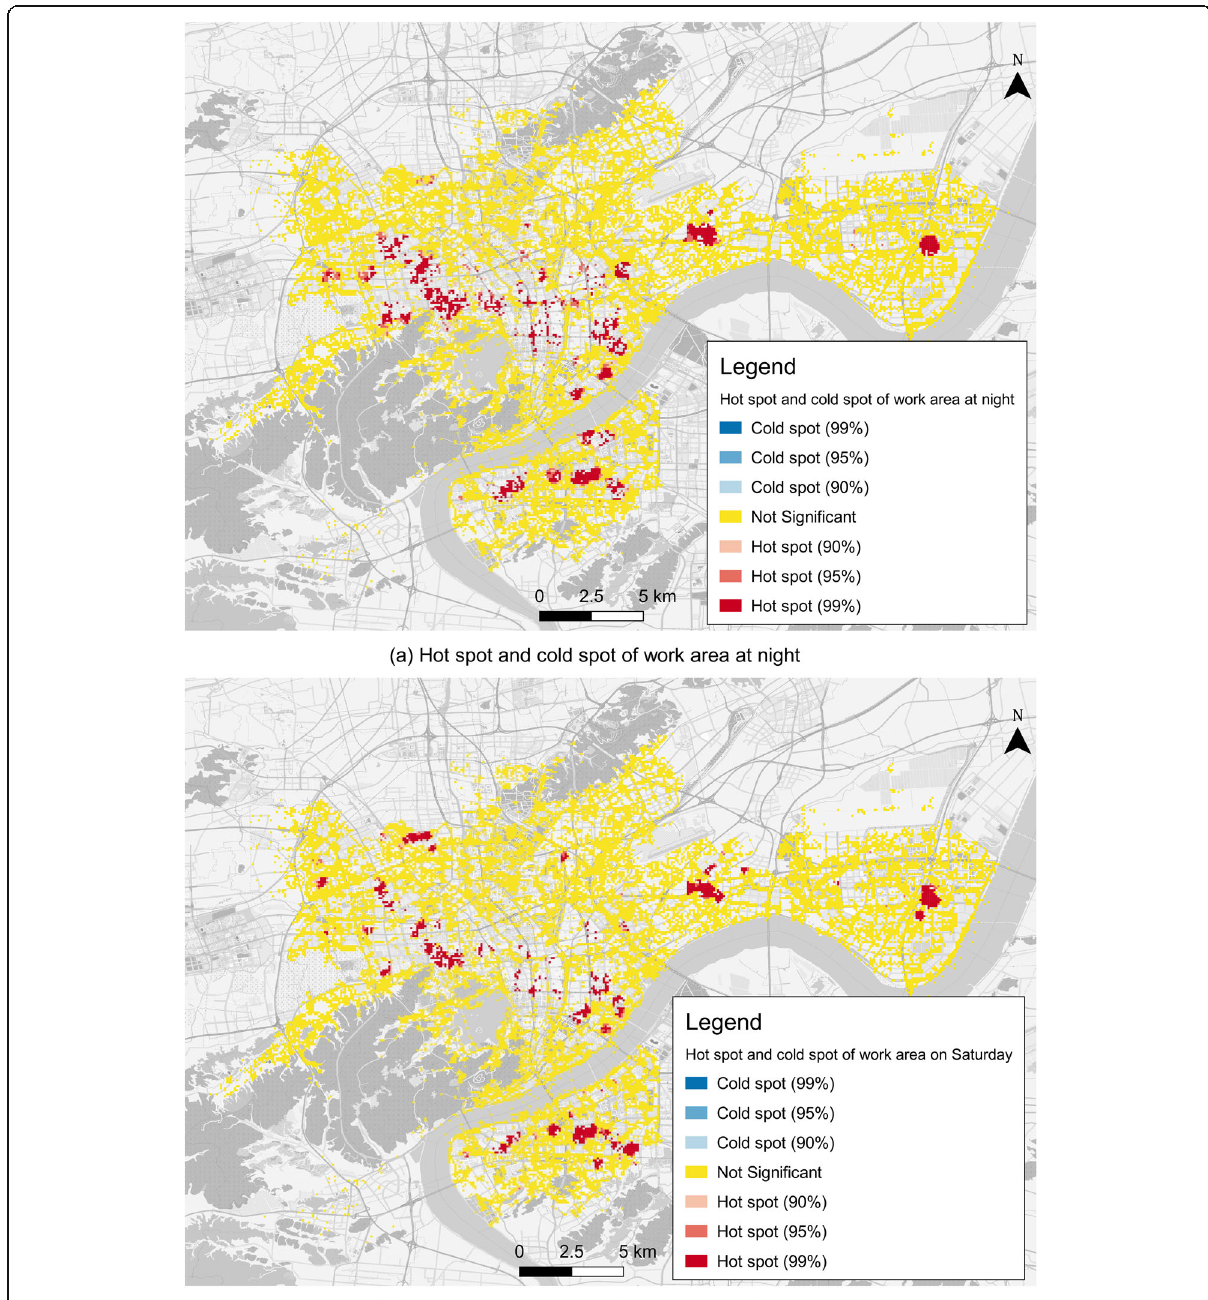
Fig. 9 Hot spot and cold spot of work overtime